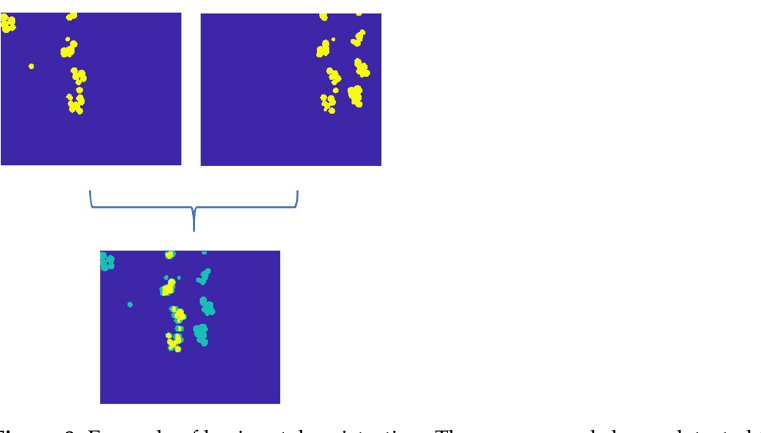
Figure 8. Example of horizontal registration. The upper panel shows detected trusses from two adja- cent column images. The lower panel shows the result of horizontal overlap, with nonoverlapping tomatoes shown in green and overlapping tomatoes shown in yellow. Again, good overlap can be observed where the column images